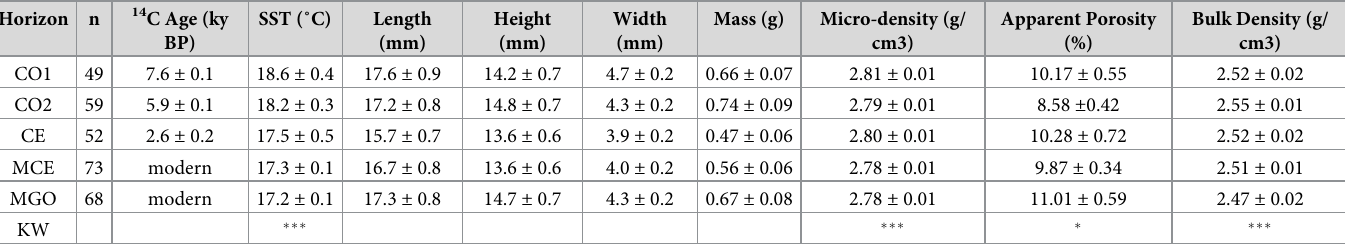
Values for each horizon in chronological order. Radiocarbon measurements are reported in years ‘before present’ (BP). Holocene SST are extrapolated from Jalali et al . [36]. For each parameter mean value and standard error are reported. n = number of collected specimens. K-W = Kruskal-Wallis equality-of-populations rank test; � p < 0.05, ��� p < 0.001.